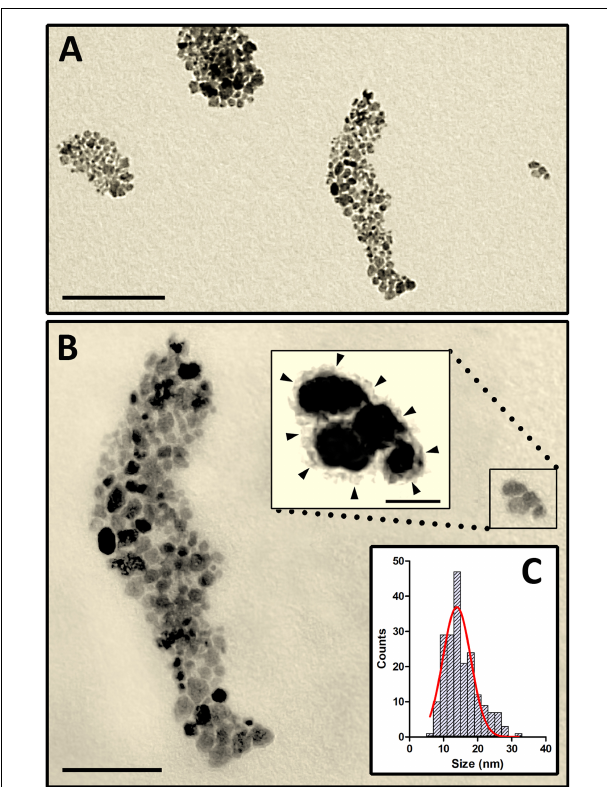
FIGURE 1 | High resolution TEM images showing aggregates of MNP-OCT in a diluted water suspension (A) . (B) Is a higher power of the right half of (A) . The inset is a higher power of the boxed area showing a small group of MNP-OCT. The brightness and contrast of this image were modified with Adobe Photoshop to visualize the organic coating surrounding the magnetite core (arrowheads). (C) Shows the histogram and the fitting Gaussian curve used to extract the average particle size. Scale bars, 200 nm in A ; 100 nm in B ; 20 nm in the inset.